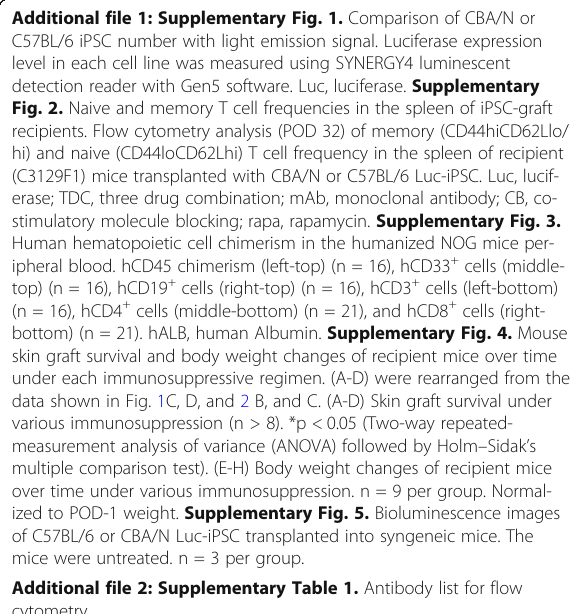
Fig. 2. Naive and memory T cell frequencies in the spleen of iPSC-graft recipients. Flow cytometry analysis (POD 32) of memory (CD44hiCD62Llo/